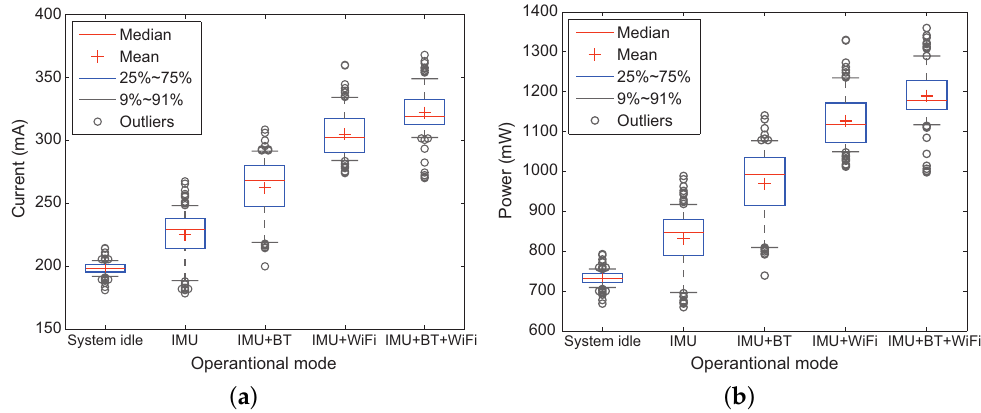
Figure 16. Statistics of the measured ( a ) current and ( b ) power in various experiment